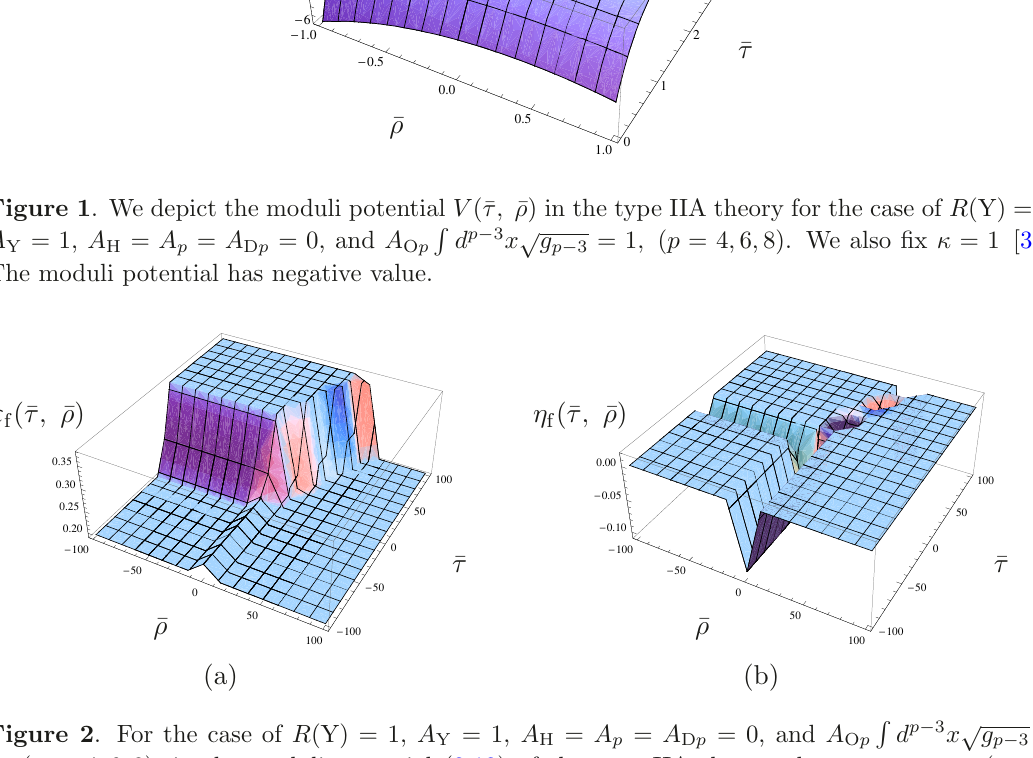
d p − 3 x √ g p − 3 = R